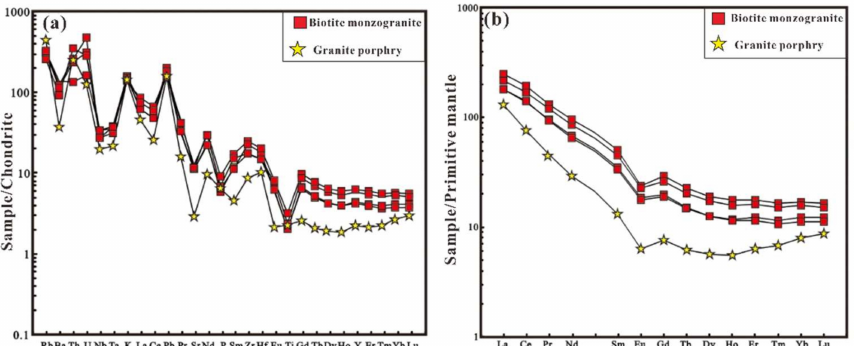
Figure 7. Primitive mantle-normalized trace-element spider diagram ( a ) and chondrite-normalized rare-earth-element pattern ( b ) for the Nianzigou granite (Sun and McDonough, 1989)